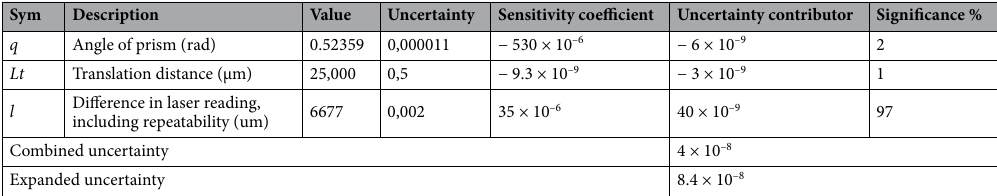
Table 2. Uncertainty budget for prism refractometer at the 25 mm position